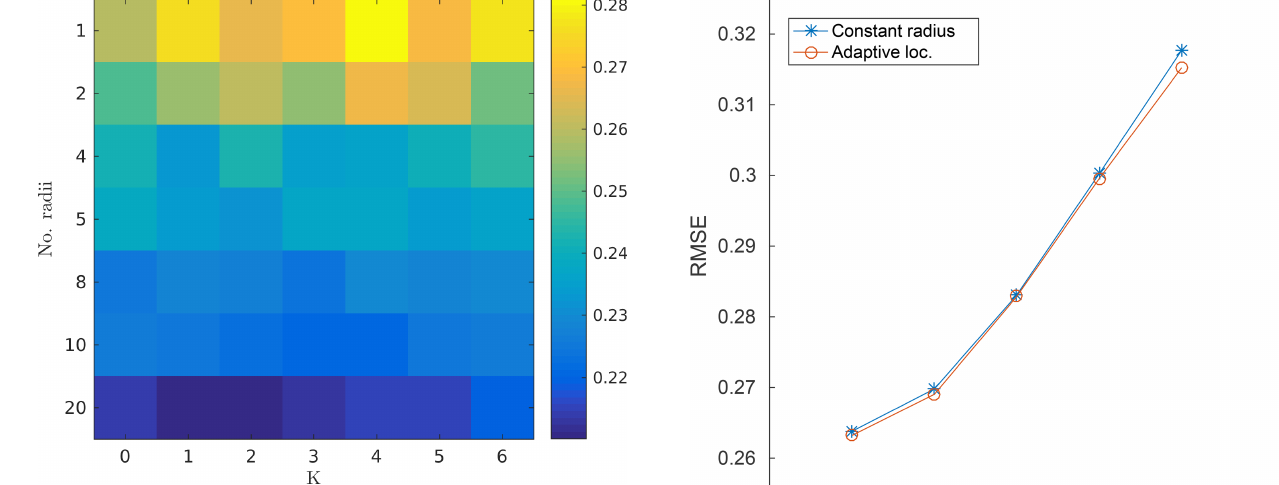
Figure 2. Time-dependent 4-D oracle for Lorenz’96. Comparison of the RMSE for a radius oracle that is both multivariate and time- dependent. The y axis represents the number of independent radii values (groups of the model state components). The assimilation cycle interval is [ 100 , 1100 ] ; a fixed inflation value of α = 1 . 02 and the function m mean are used.